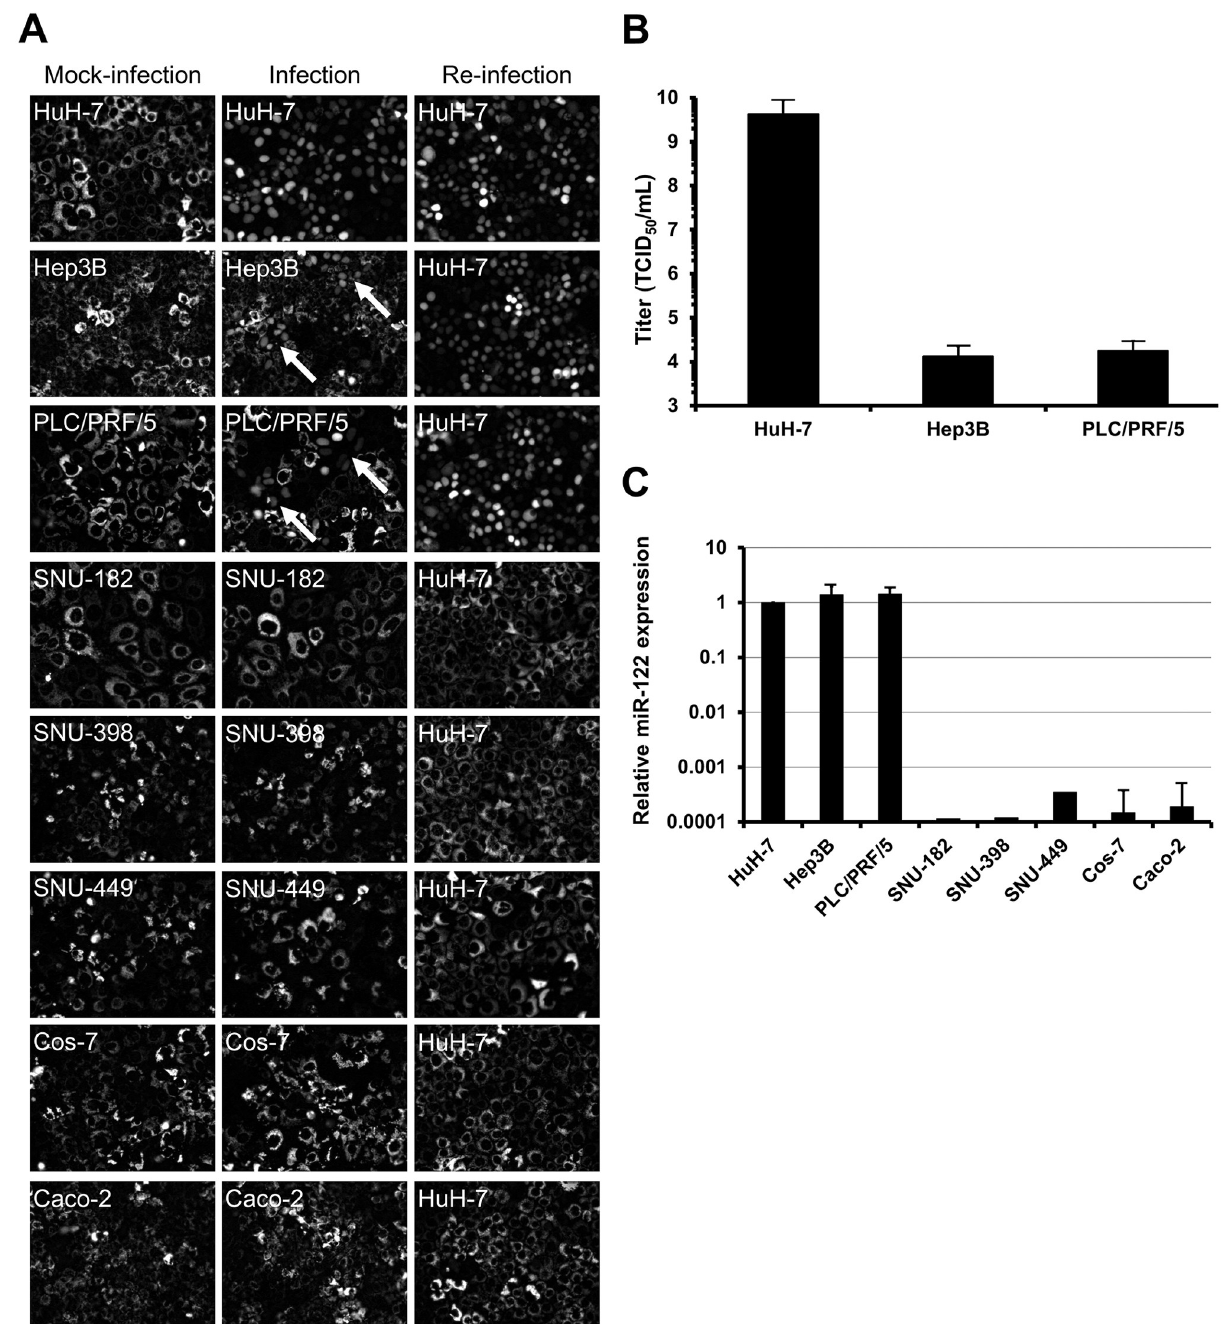
Fig 6. Infection of hepatoma cell lines with cell culture adapted HCV. ( A ) HuH-7, Hep3B, PLC/PRF/5, SNU-182, SNU-398, SNU-449, Cos-7 and Caco-2 cells transduced with lentivirus expressing RFP-NLS-IPS were mock-infected (left) or inoculated with i24 (middle) (MOI = 10000 HuH-7 infectious units per cell). Infected cells, identified by translocation of the cleavage product RFP-NLS to the nucleus, were visualized 48 h post-infection. The supernatants of inoculated cells were recovered 72 h post-infection, centrifuged and used to inoculate naive HuH- 7-RFP-NLS-IPS to check the production of progeny virus (right). Images are representative of three independent experiments. ( B ) The permissivity of HuH-7, Hep3B and PLC/PRF/ 5 cells to the cell culture adapted virus was determined by TCID 50 assay. The results are expressed as TCID 50 /mL ± S.D. calculated on 8 wells. ( C ) miR- 122 expression was determined by RT-qPCR in HuH-7, Hep3B, PLC/PRF/5, SNU-182, SNU-389, SNU-449, Cos-7 and Caco-2 cells. The results, which are representative of four independent experiments, are expressed as relative miR-122 expression using the ΔΔ Ct method with RNU6B as endogenous control and HuH-7 cells as